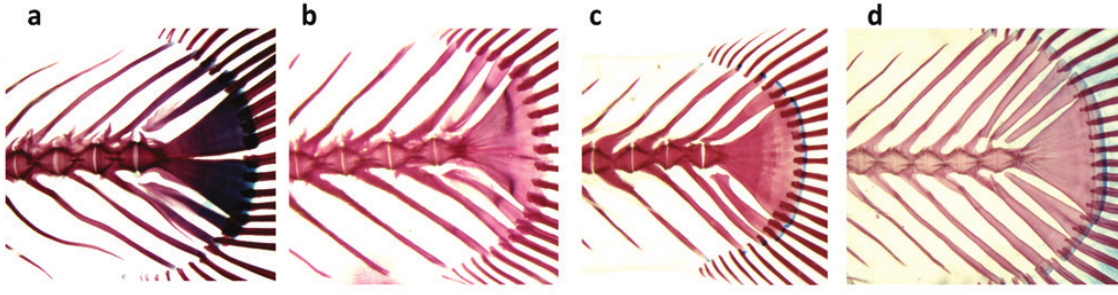
Fig. 7. Caudal skeleton of a. Pterolebias longipinnis , b. Papiliolebias bitteri , c. Cynopoecilus melanotaenia , d. Austrolebias wolterstorffi . Scale bar = 1 mm.